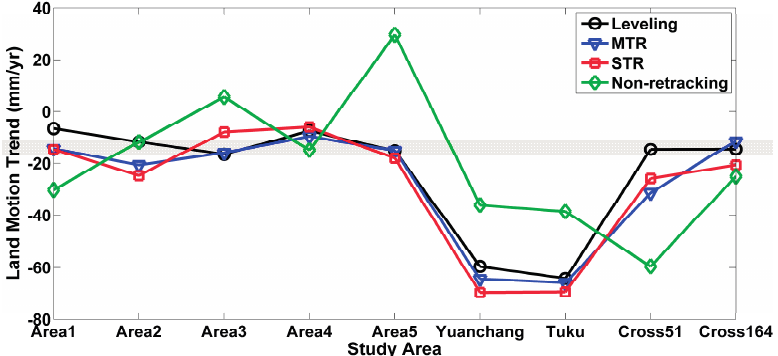
Figure 11. Comparison of the vertical land motion trends in the nine study regions. The black, blue, red, and green curves represent the vertical motion trends derived from leveling, altimetry retracked by MTR and STR, and non-retracking altimetry, respectively. The vertical displacement rate field of Taiwan, regarded as independent measurements and calculated from the precise geodetic leveling data at 1843 solidly constructed benchmarks from 2000–2008 [6], was used to evaluate the estimated vertical land motion trends from altimetry. Leveling-derived vertical motion rates at points of altimetry ground tracks in the nine study areas were estimated from the rates of averaged in each area, corresponding to the along-track space of 12 km or two 1-Hz LSAs,